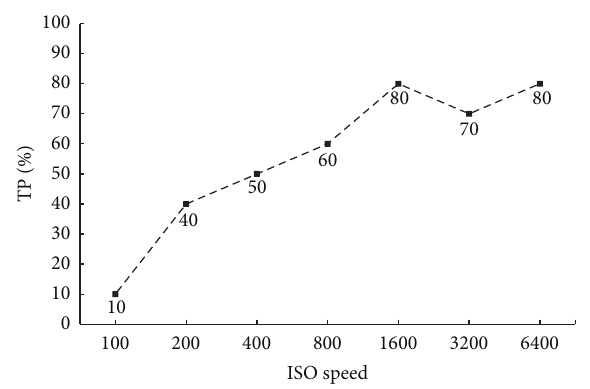
Figure 14: TP rate in different ISO